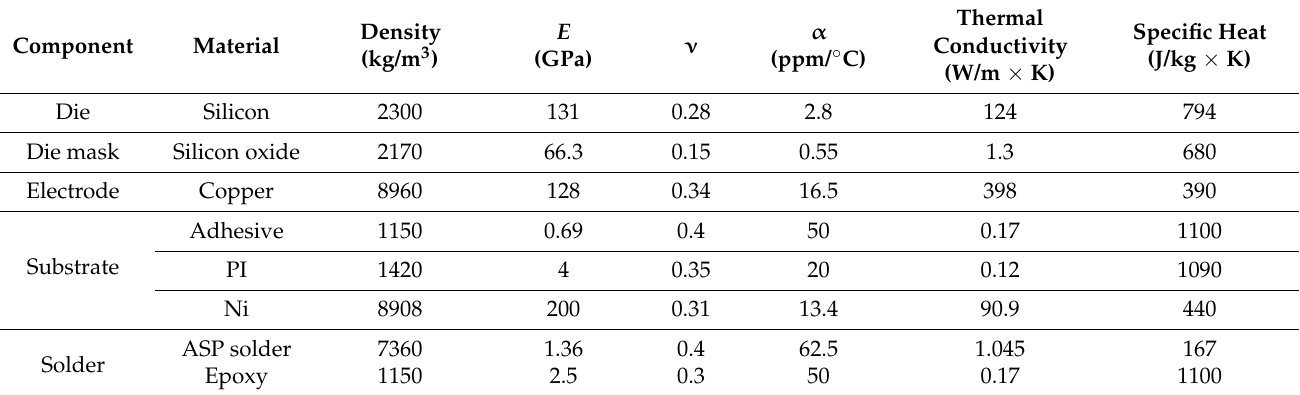
Figure 6. Meshing structure of the FEM model used for the flexible package. Table 1. Material properties used in the numerical simulation.